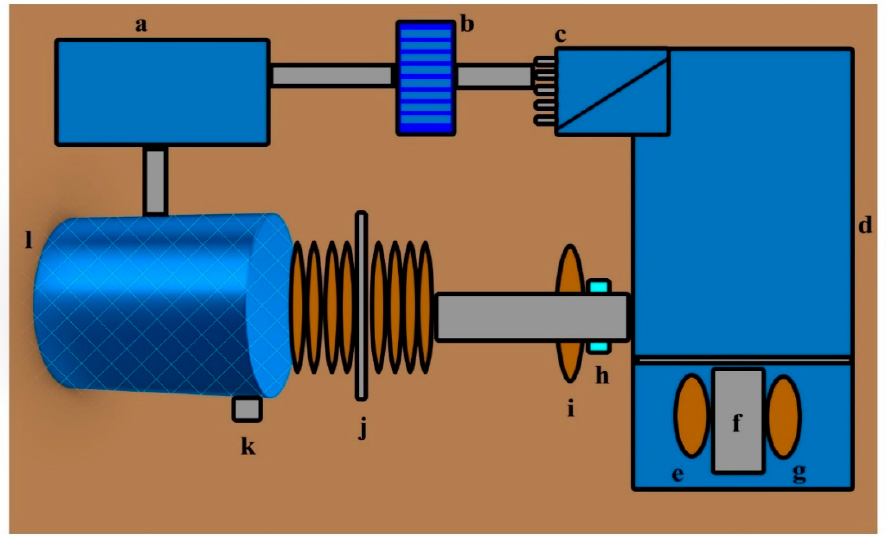
Figure 6. An illustration of PRONOSTIA testbed for bearing run-to-failure dataset. In the figure. (a) NI CDA Q cards, (b) a pressure regulator, (c) cylinder pressure, (d) a force sensor, (e) the bearing tested, (f) accelerometers, (g) platinum RTD, (h) coupling, (i) a torquemeter, (j) a speed reducer, (k) a speed sensor, and (l) an AC motor.